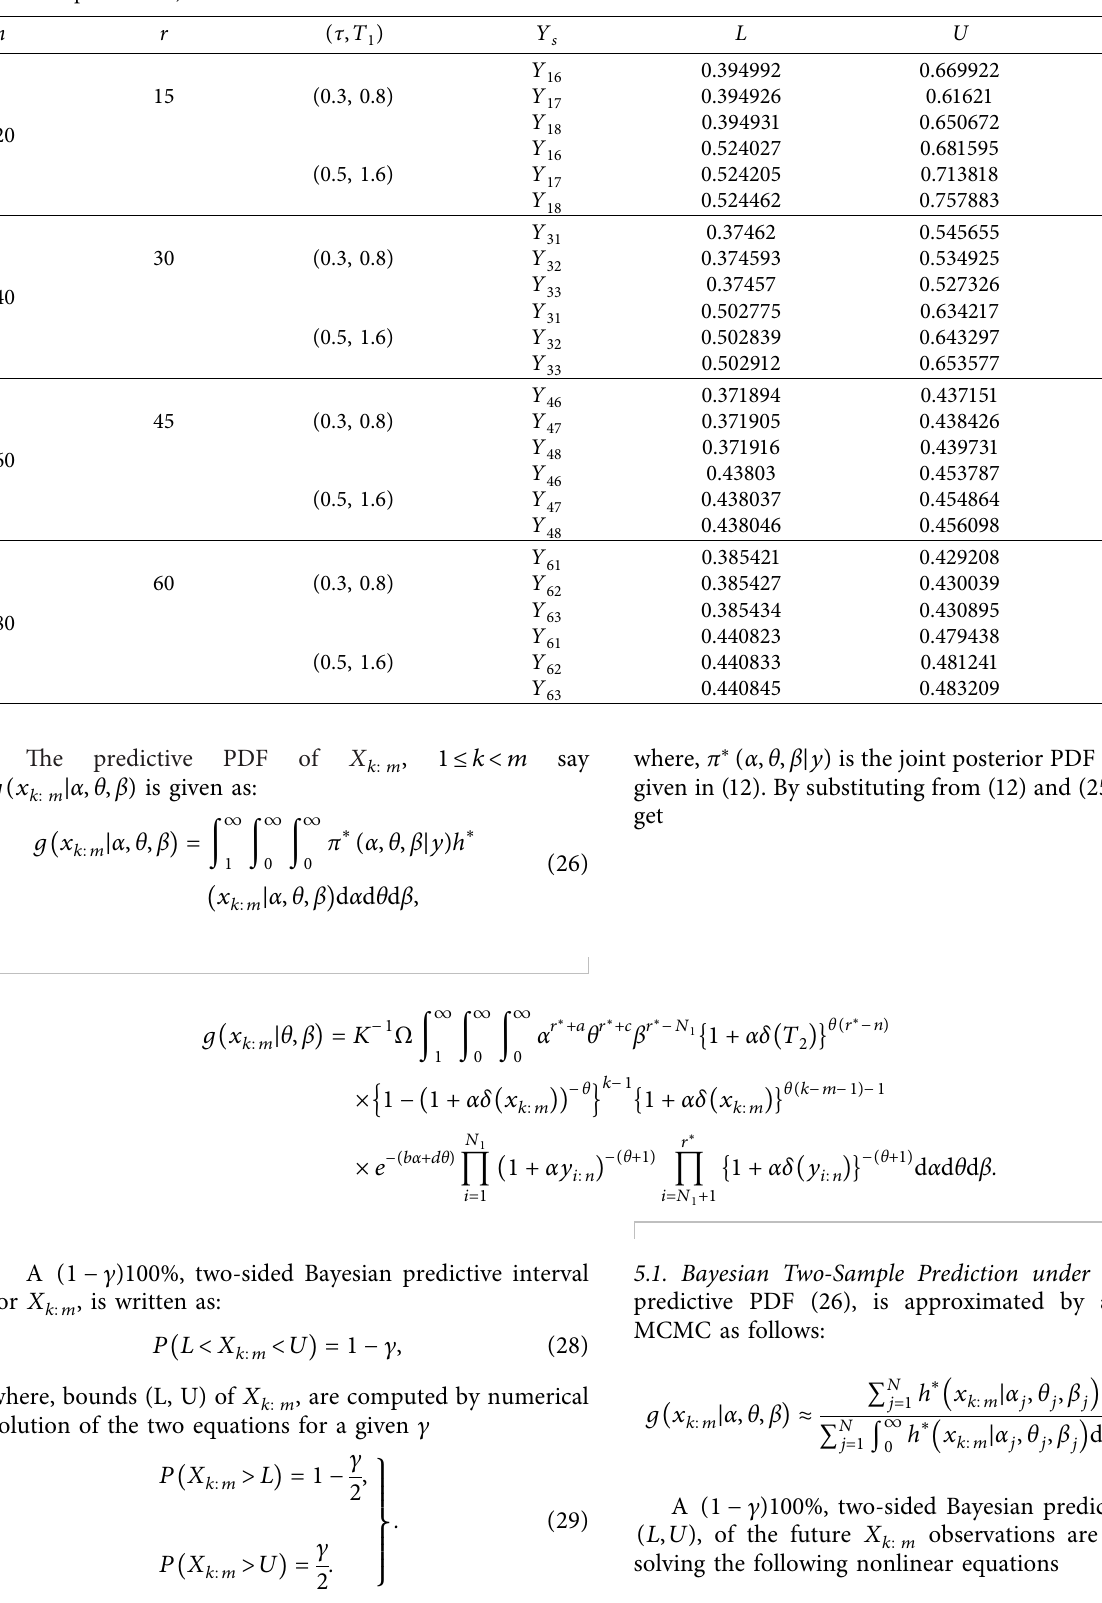
Table 1: 95% Bayesian predictive intervals of future order statistics when θ � 2 . 5, α � 1 . 8, β � 3 . 5, a � 0 . 8, b � 0 . 6, c � 0 . 6, and d � 0 . 7 (one-sample